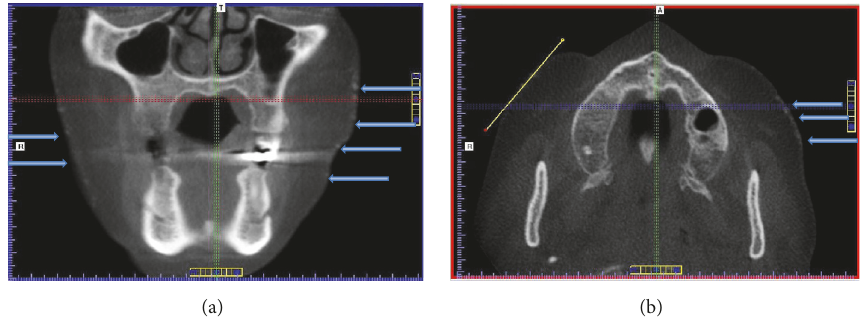
Figure 2: (a) CBCT coronal view. (b) CBCT axial view showing numerous radiopaque small concentric nodules in the soft tissues below the level of the zygomatic arch and lateral to the buccinator